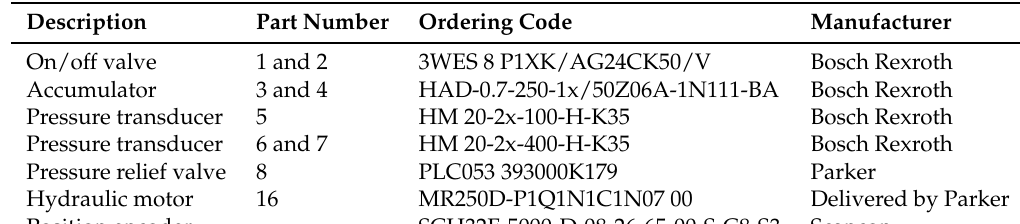
Table 2. Part list of the modified motor.